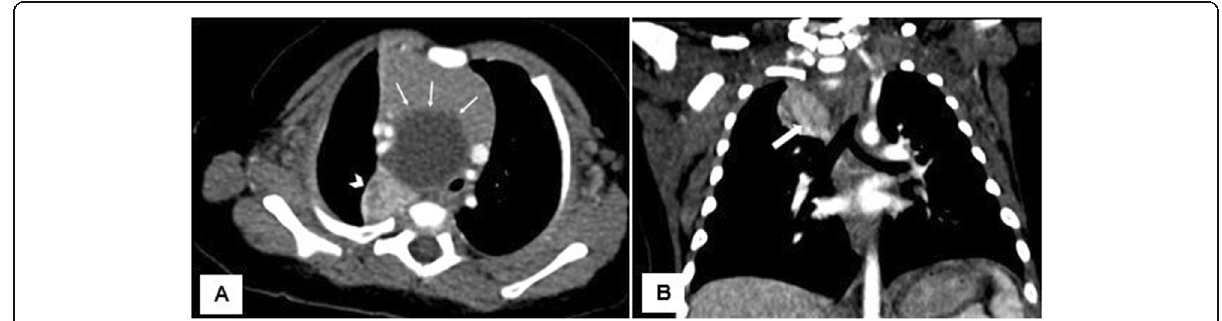
Fig. 1 Axial ( a ) contrast-enhanced CT of the chest of a 3-month-old male infant showing a median cystic mass (arrows) causing tracheal deviation and compression, as well as a mass effect on the more anterior thymus, was pathologically demonstrated to be a bronchogenic cyst. A posterior right upper lobe hyperdense consolidation (arrowhead) with anomalous venous drainage to the distal SVC (block arrow), consistent with pulmonary sequestration, is better demonstrated on the coronal image ( b